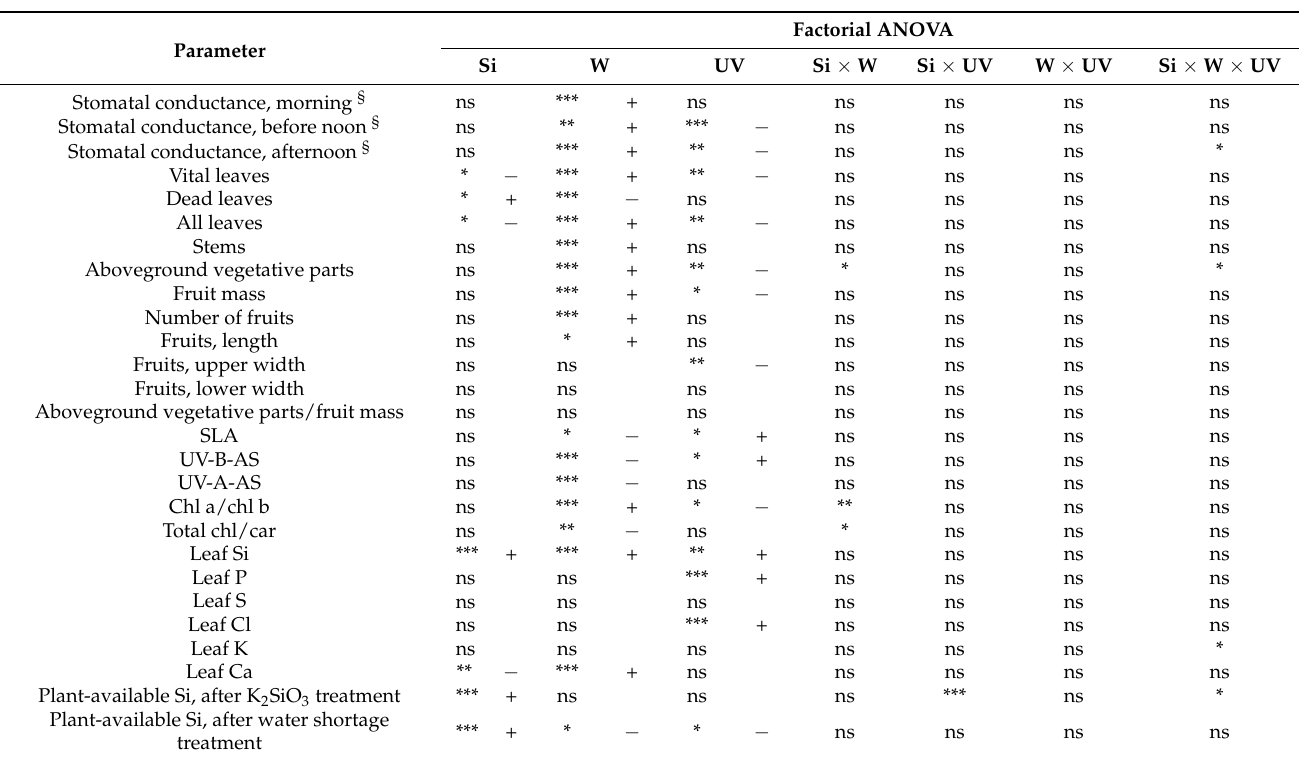
Table 2. Effects of K 2 SiO 3 addition, water availability, ambient UV radiation, and their interactions on selected parameters for cucumber plants and